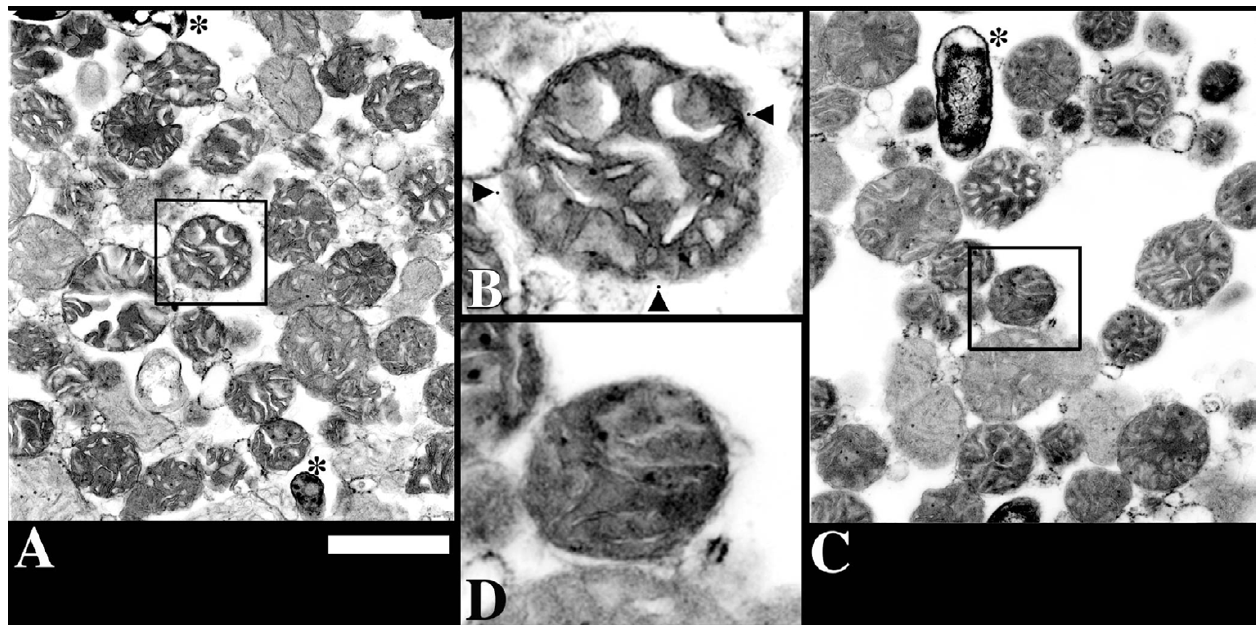
Figure 2 Conventional electron micrographs of thin sections of liver mitochondria assayed the quality of tBid G94E labelling. a) Section of pelleted mitochondria decorated with immunogold tBid G94E . Most of the mitochondria are in the condensed state [33]. No dif- ference in the general number of gold particles between condensed and orthodox mitochondria was observed. Peroxisome contamination indicated by asterisks in (a) and (c) had no immunogold background labeling. b) Mitochondrion boxed in (a) mag- nified 3x in order to visualize the 5-nm gold particles (arrowheads). c) No-primary control section showing little, if any, non- specific immunogold labeling on mitochondria treated with gold-conjugated secondary antibody. d) Mitochondrion boxed in (c) magnified 3x in order to show that there is no gold around the perimeter. Scale bars: (a), (c), 1000